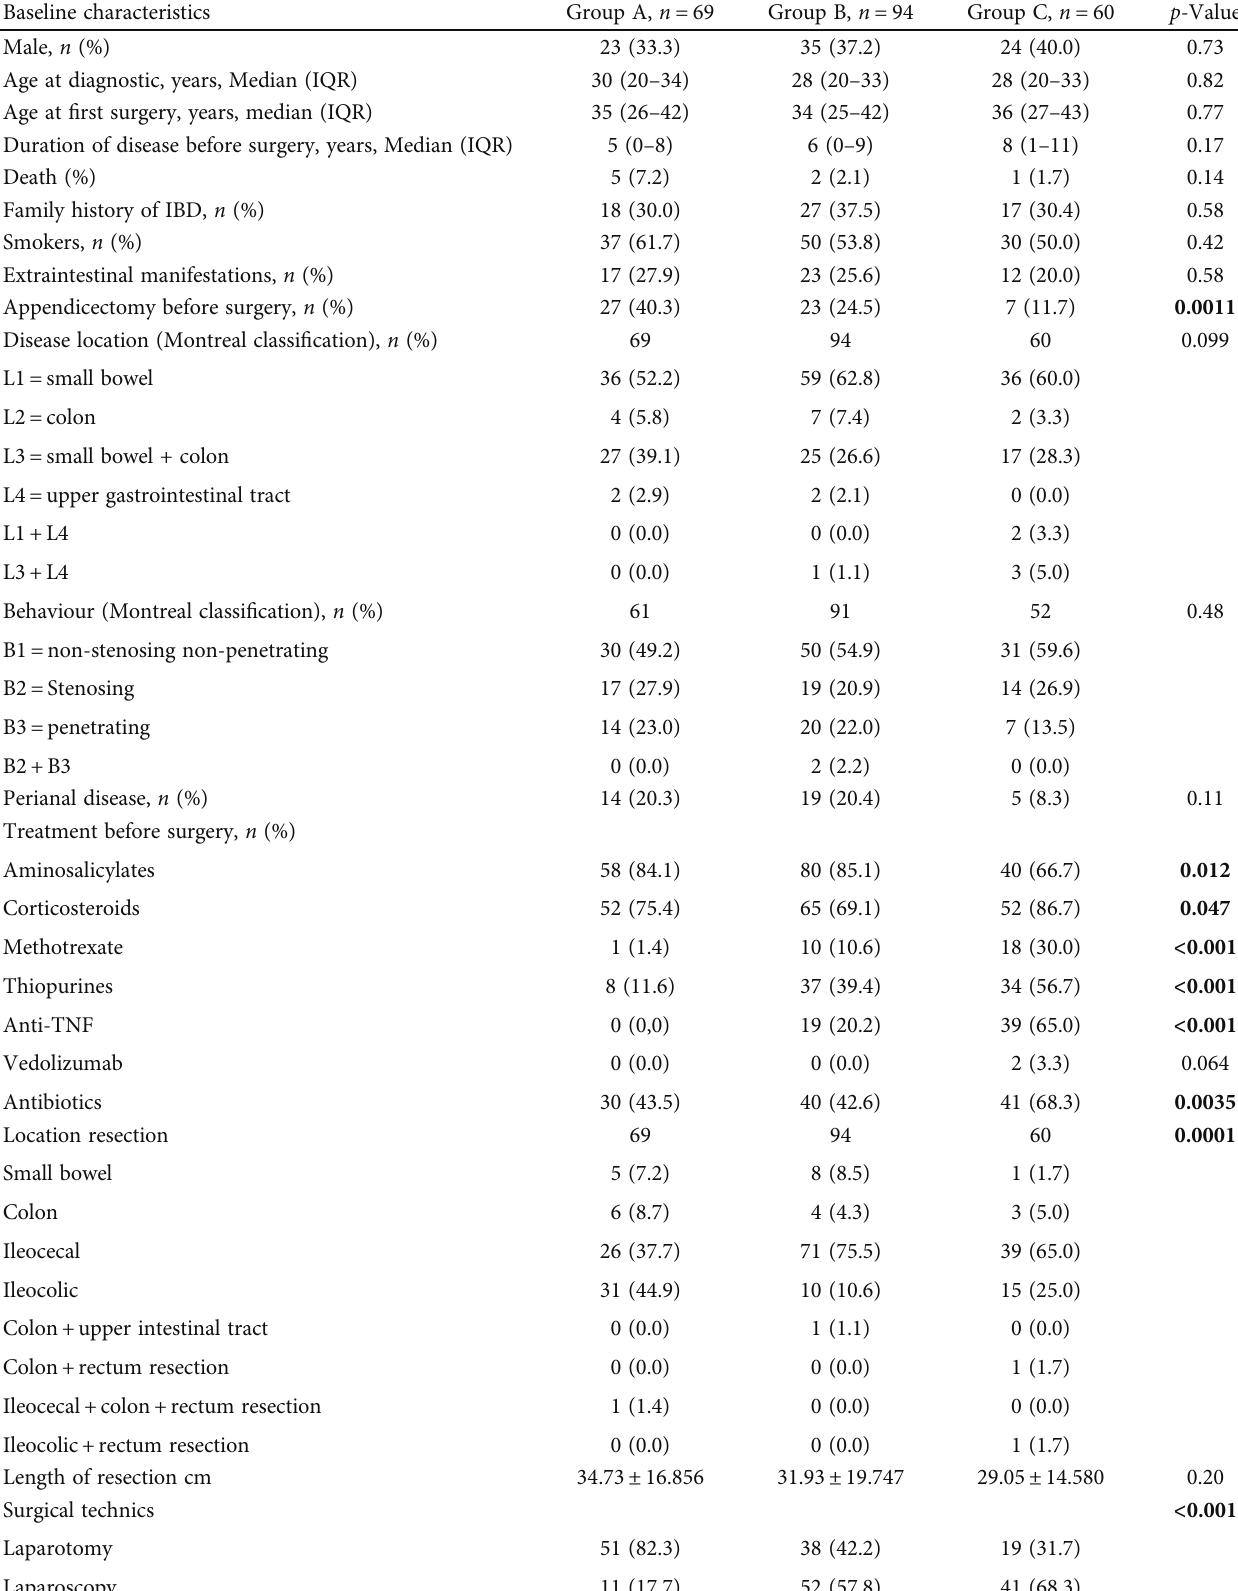
Table 1: Baseline characteristics of the patients. (CC =corticosteroids; MTX =méthotrexate; IQR: interquartile